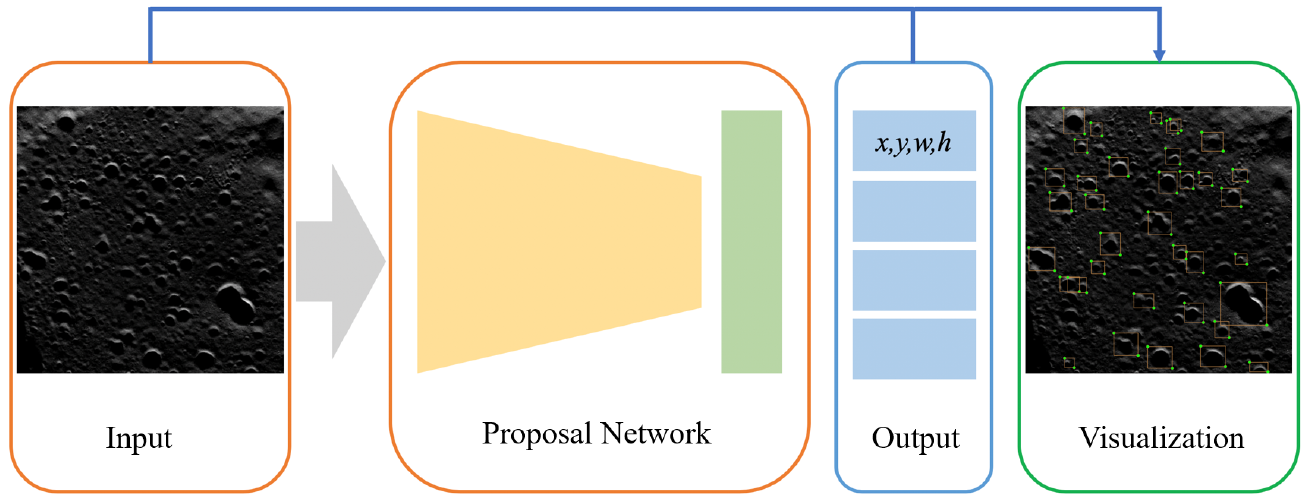
Figure 7. Structure of the auxiliary